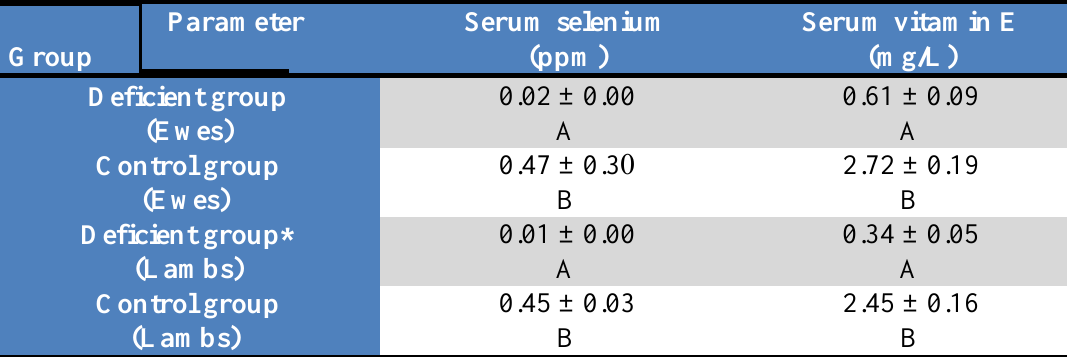
Table (1) Selenium and Vit E levels in serum of ewes and their newborn lambs Parameter